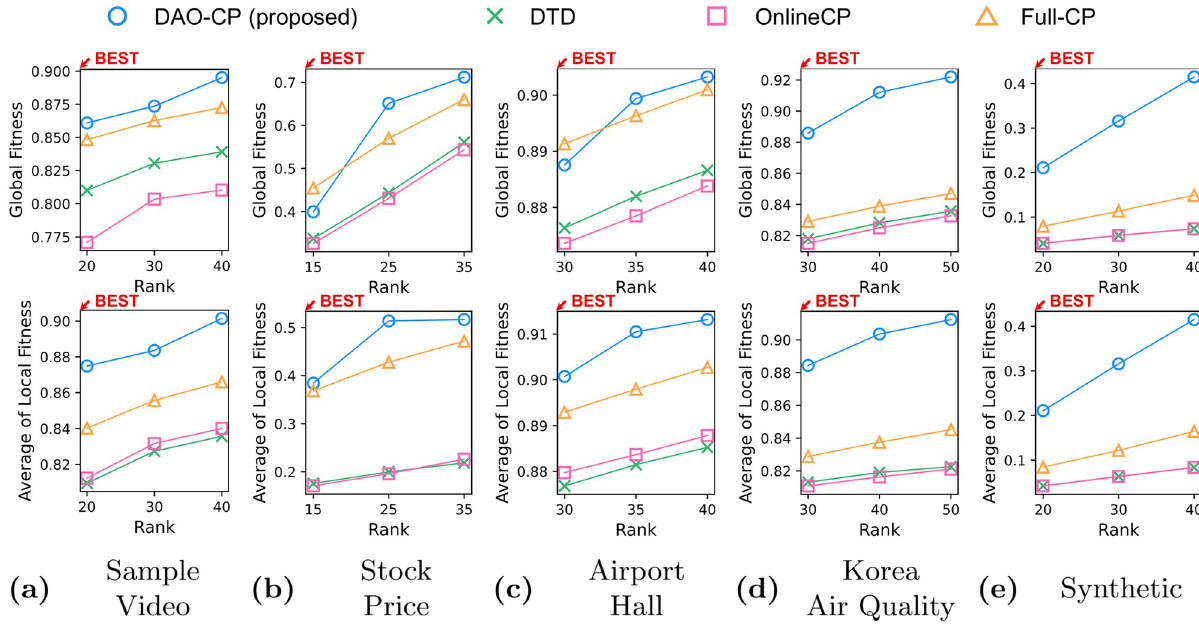
Fig 4. Reconstruction errors: Global (upper) and local (lower) fitness. Since Full–CP is not an online method, we evaluate its fitness whenever a new slice is added. Detecting the change points of theme, DAO-CP successfully increases the accuracy of decomposition, which is even higher than that of